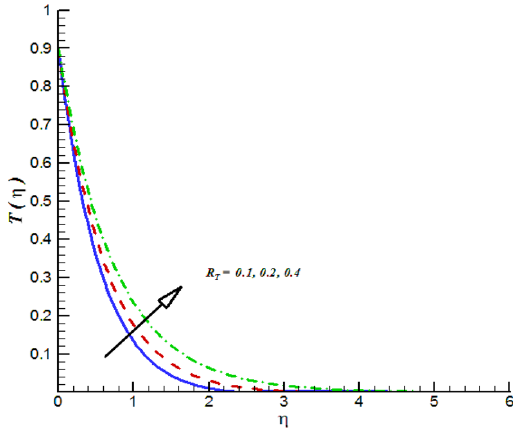
Figure 18. Impact of R T on T ( η ).